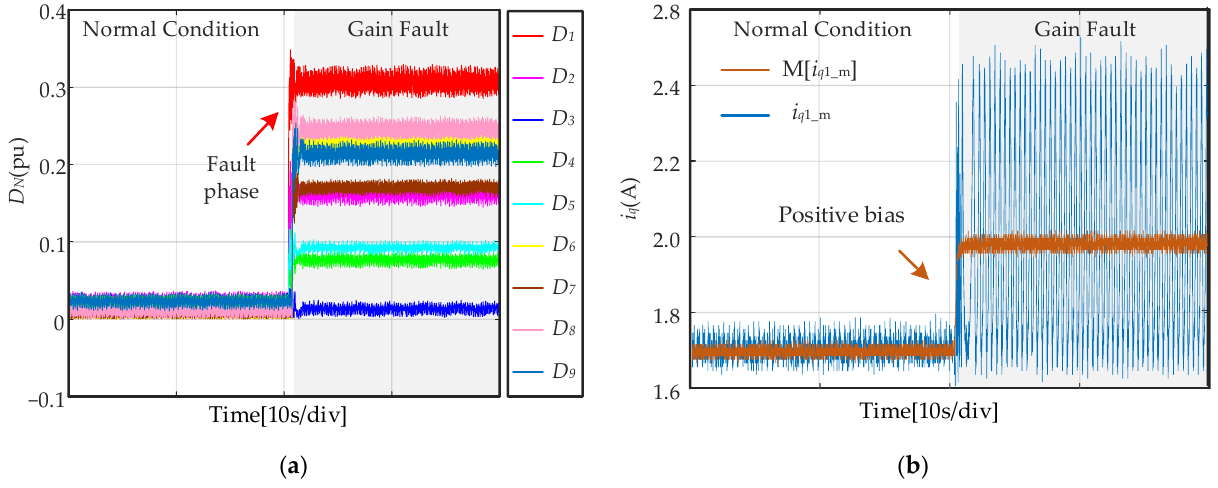
Figure 13. ( a ) D N in gain fault; ( b ) M[ i q 1_ m ] and i q 1_ N in gain fault.